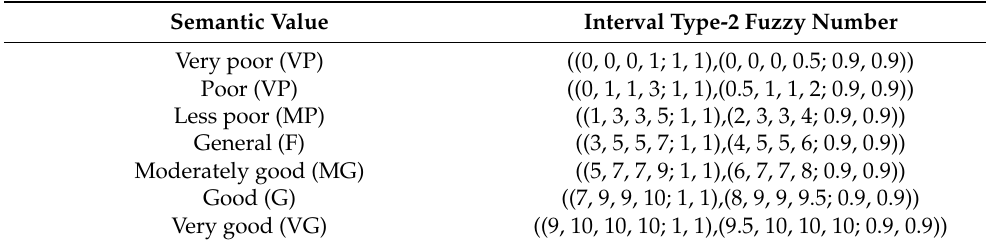
Table 3. Relationship between rated linguistic variables and interval type-2 fuzzy numbers. Semantic Value Interval Type-2 Fuzzy